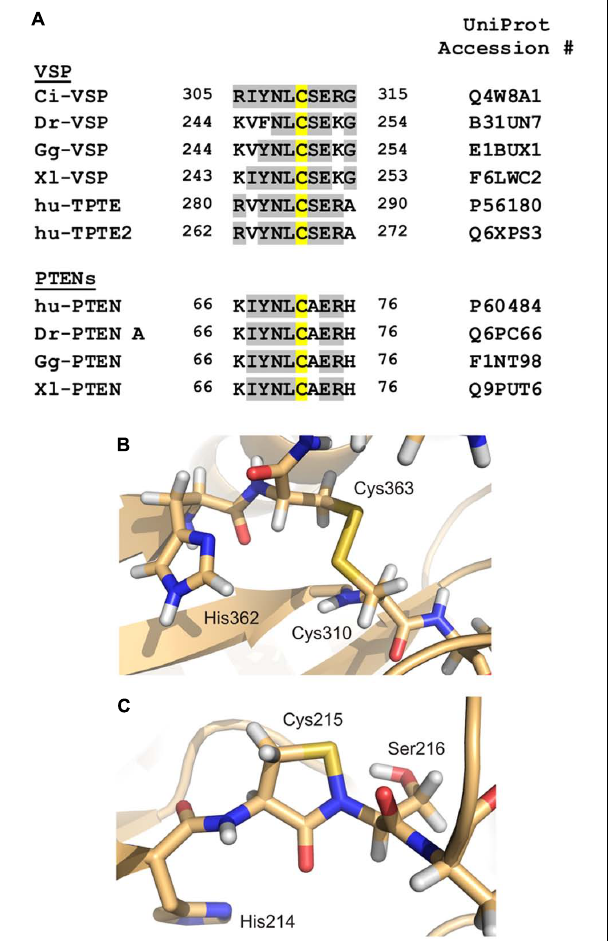
FIGURE 5 | Redox modification of the catalytically active side chain in cysteine-based PTPs. (A) The amino acid motif of Ci-VSP, which contains Cys310 as putative interaction partner for the disulfide-bridge with the catalytic Cys363, is aligned with sequences ofVSP homologs from various species (Dr, Danio rerio ; Gg, Gallus gallus ; Xl, Xenopus laevis ; hu, human). Additionally, PTEN isoforms from different species are included in this alignment. Amino acid identities to Ci-VSP are colored in gray. Cys310 and the corresponding position in the respective proteins are marked in yellow. (B) For Ci-VSP, the disulfide bridge between Cys310 and the catalytic Cys363 is shown as it has been identified in a crystal structure of the cytosolic domain (PDB accession number 3awg; Matsuda etal., 2011). (C) In crystal structures of the human PTP1B, the formation of a sulphenyl-amide bond has been observed between the P-loop Ser216 and the catalytically active Cys215 (PDB 1oes; van Montfort etal.,